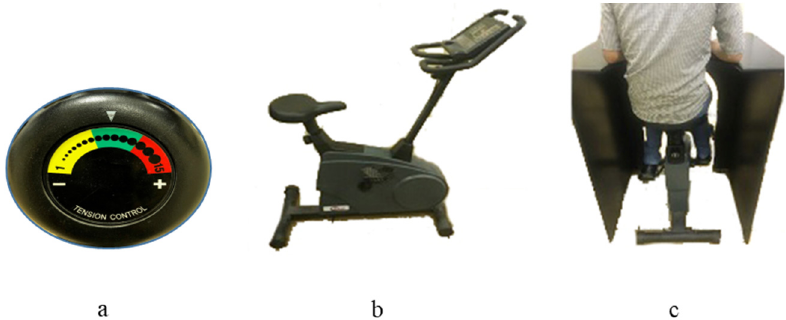
Figure 3. Experimental setup: ( a ) tension control; ( b ) stationary bike; ( c ) adjusting work station.